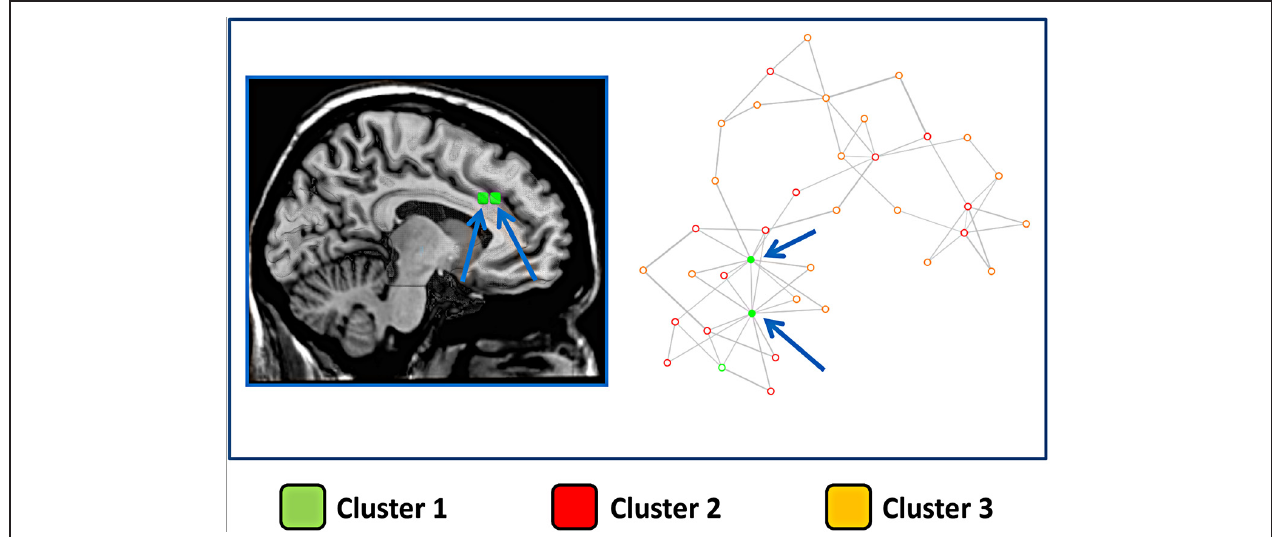
representation is optimized using a force-directed layout algorithm (Fruchterman–Reingold). Arrows indicate the two blocks with the highest number of connections. Left panel : the two blocks with the highest number of connections are graphically represented over a sliced standard brain